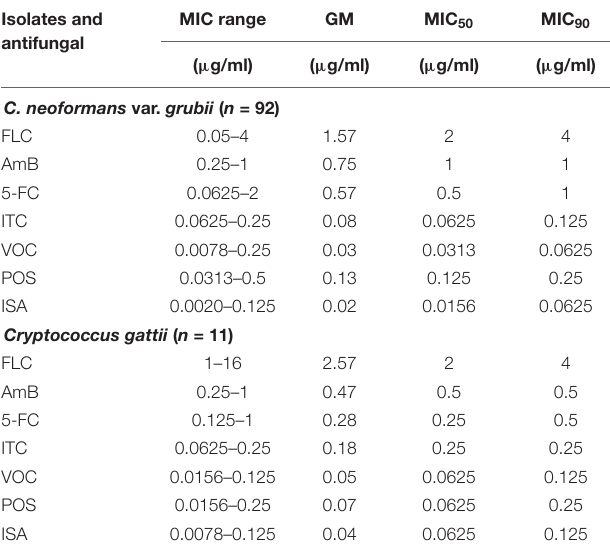
TABLE 2 | Antifungal susceptibilities for 130 Cryptococcus